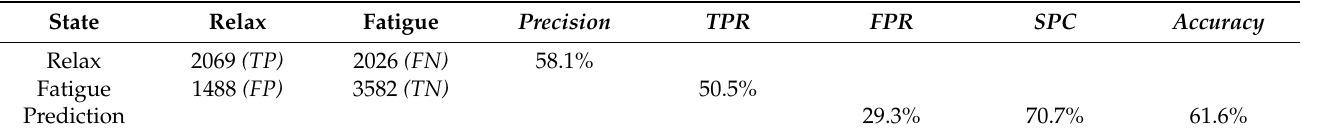
Table 2. State analysis